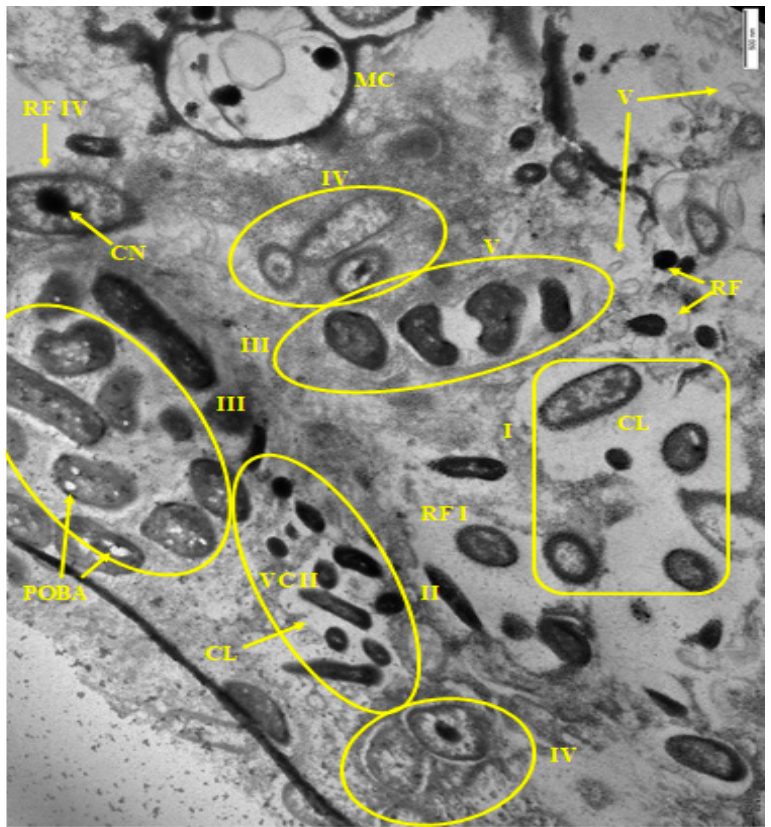
Figure 5. Electron micrograph of sample 4 biofilm. Designations: VC—vegetative cells; RF—resting forms; CL—capsular layer; I, II, III, IV, V—microcolonies of I–V morphotype cells, respectively; V—vesicles; POBA—polyoxybutyric acid, MC—meat cell. Scale bar is 0.5 µm.